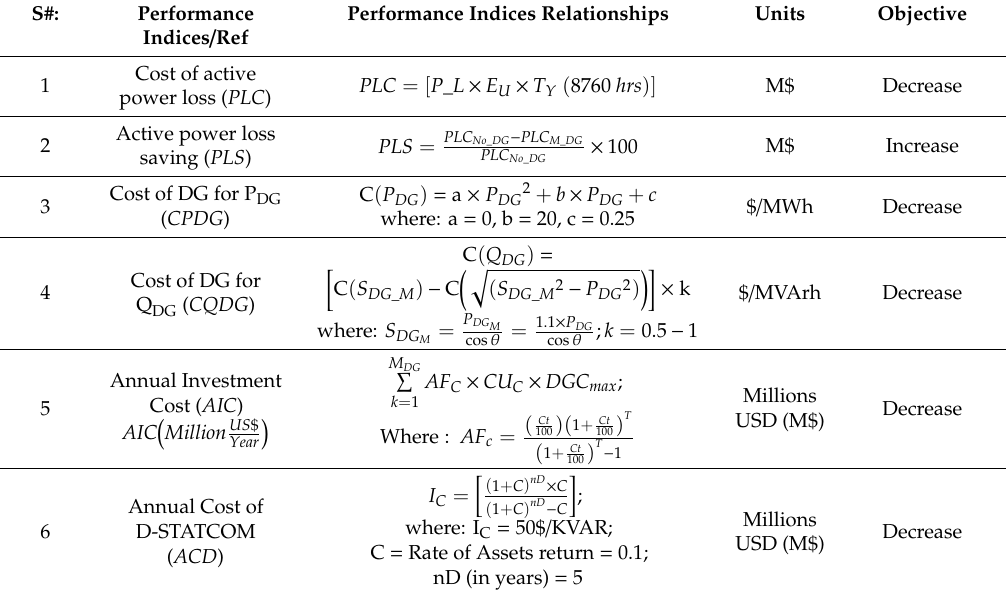
Table 4. Cost-economic indices for performance evaluation (designated as cost-economic performance evaluation